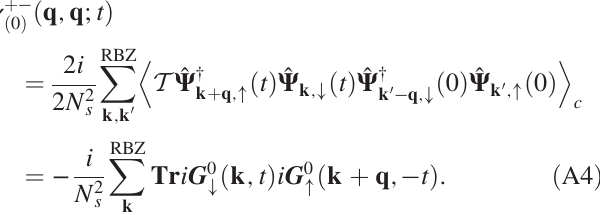
density susceptibility matrix; see Eq. (37). The sums over internal momentum k , frequency ν , and spin have not been written explicitly.